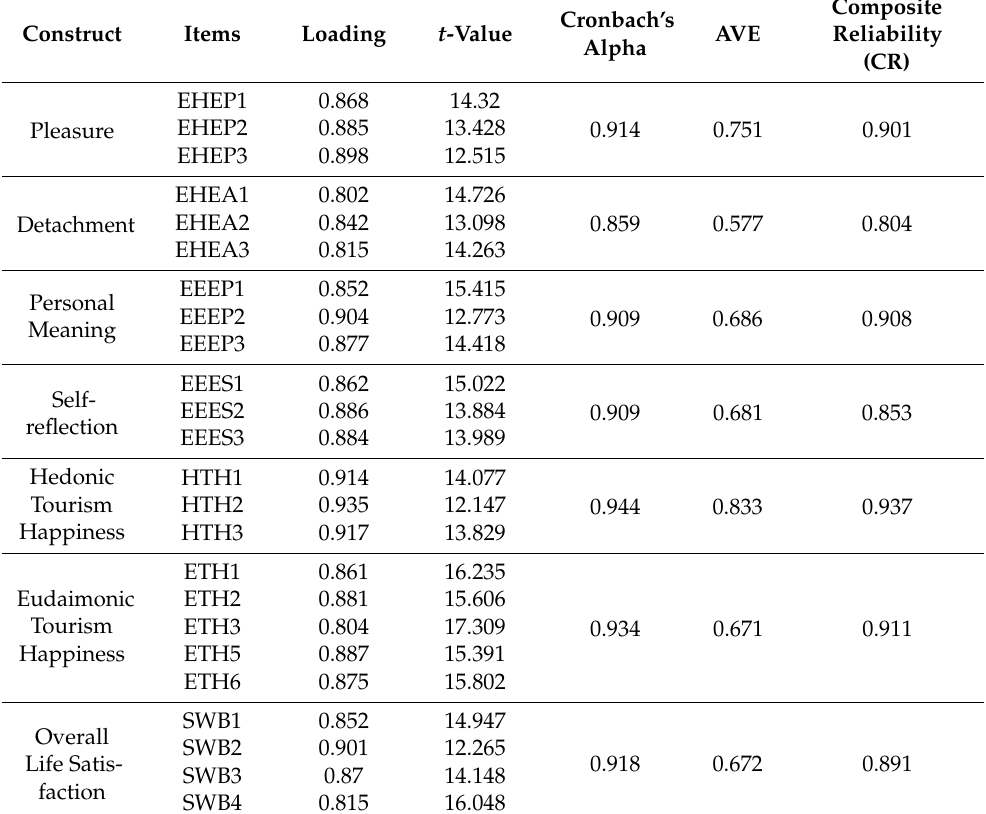
Table 4. Confirmatory Factor Analysis.